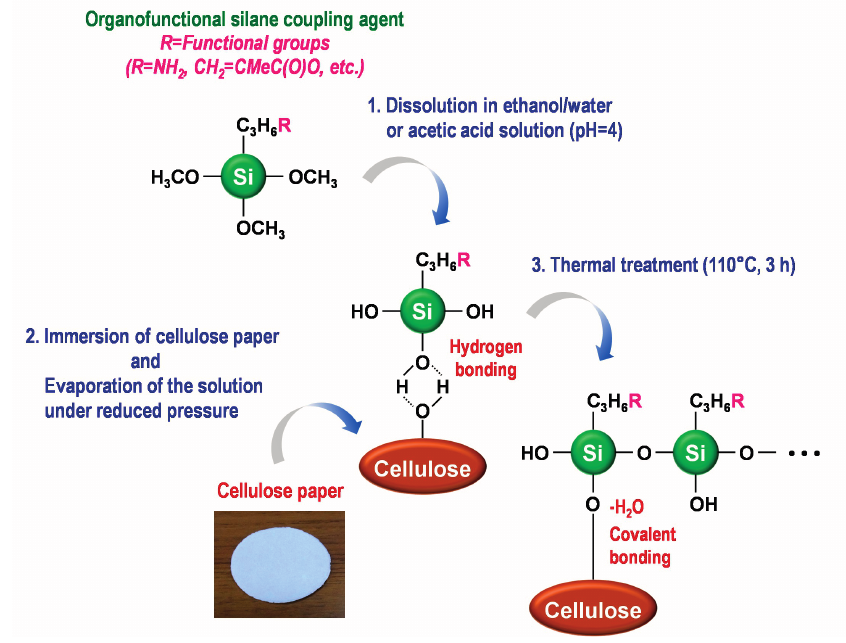
Figure 2. Schematic diagram of the silane-coupling process on cellulose paper.